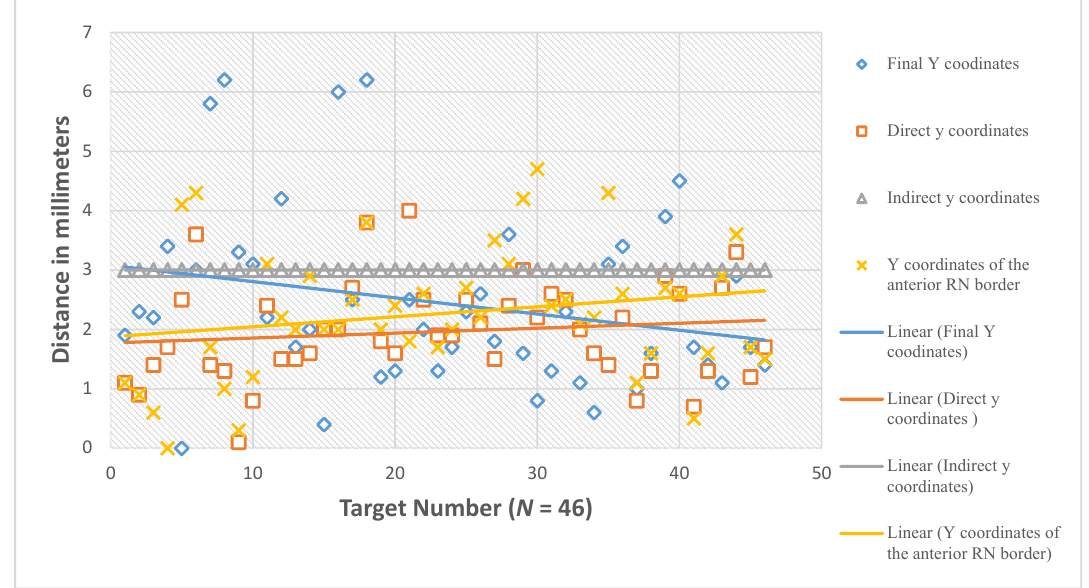
Figure 12. The Y coordinates in relation to the MCP.